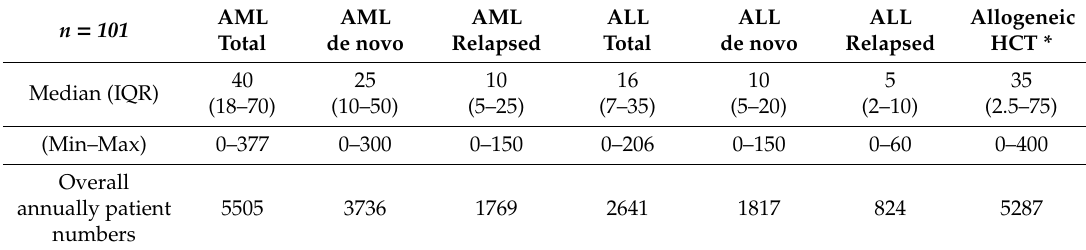
Table 2. Patient numbers treated annually (at participating sites).